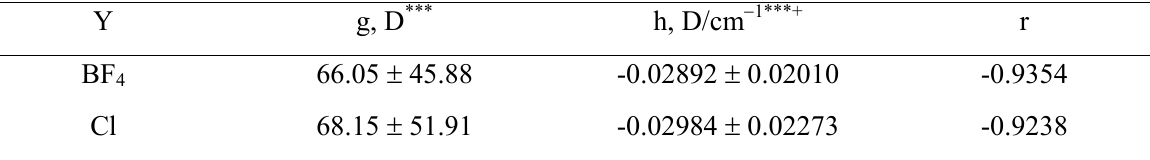
Table 4c. Correlations of mesomeric dipole moments * of X substituents with stretching vibrational frequencies ( ν ) for fragment C-N + ≡ N bonds in aryldiazonium salts 4-XC